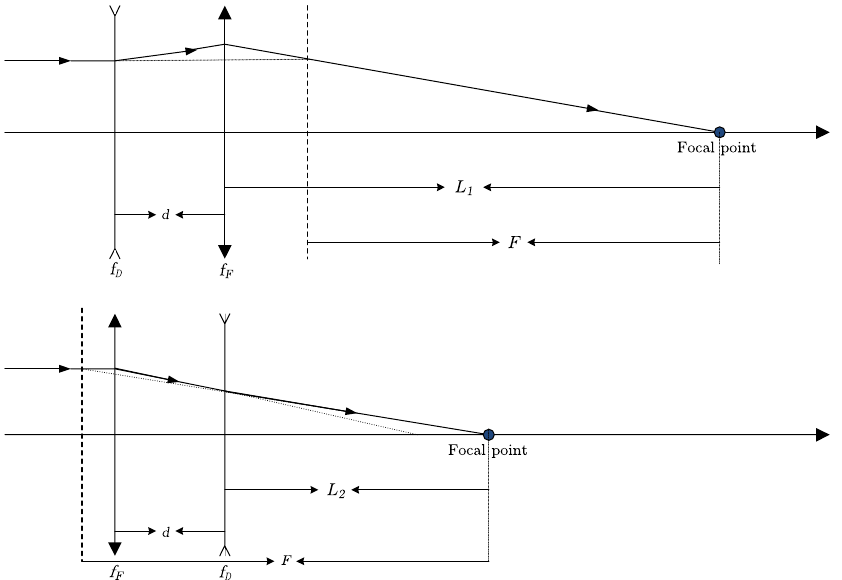
and L are the 1 2